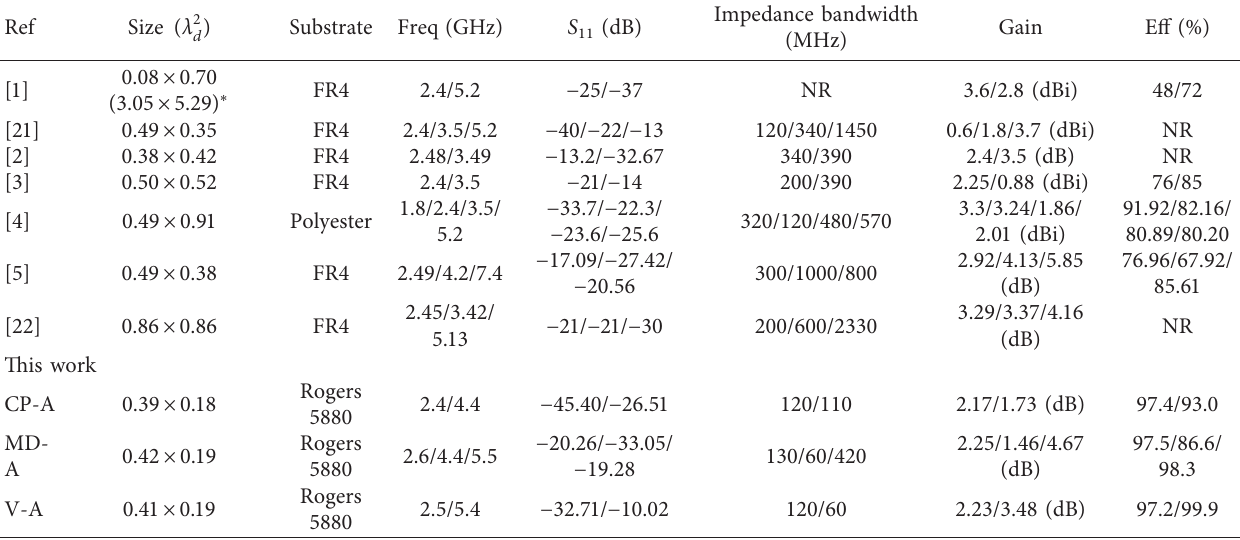
Table 4: Comparative analysis of the Bio-ACS antenna with recent works in the